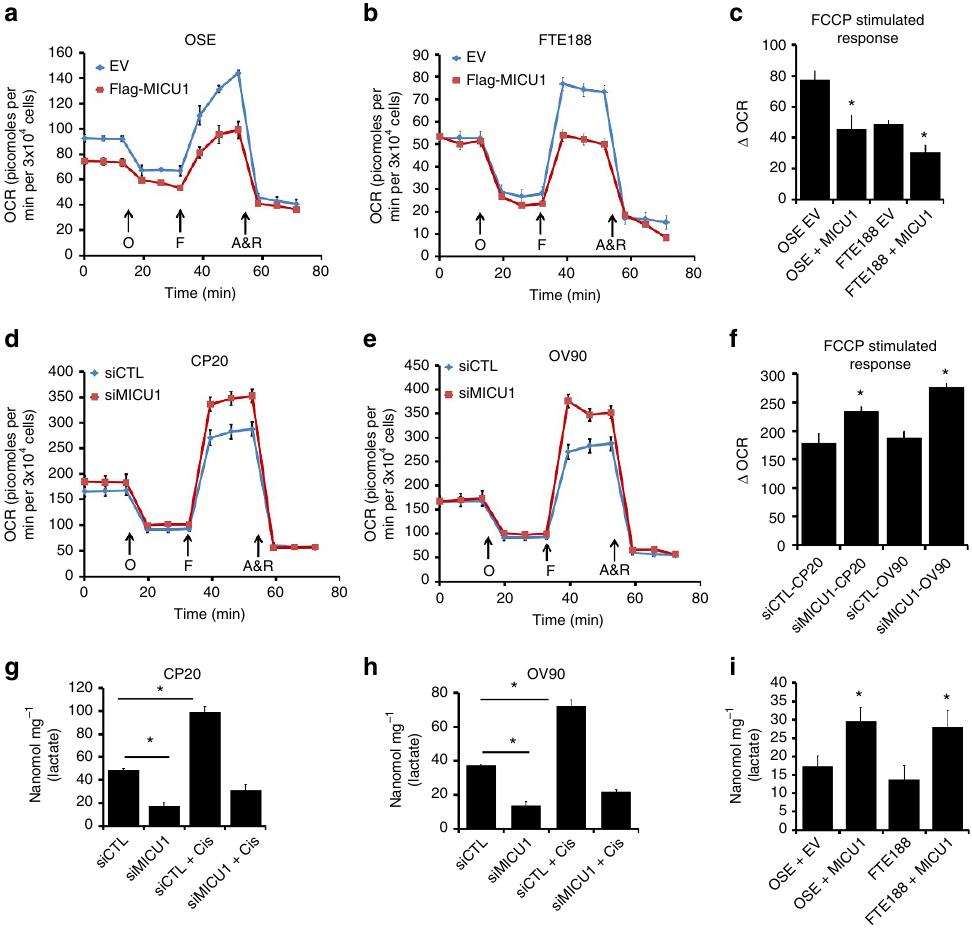
Figure 5 | MICU1 negatively regulates OxPhos function and induces lactate production. ( a , b ) Oxygen consumption rate (OCR) was measured using the Seahorse XF-96 analyser in OSE ( a ) and FTE188 cells expressing EV (empty vector) or FLAG-MICU1. An XF trace representing mean ± s.e.m. of at least three technical replicates per group is shown. Cells were sequentially treated with 2 m M Oligomycin (O), 0.5 m M FCCP (F) and 1 m M each of Antimycin þ Rotenone (A þ R) at indicated time points. ( c ) FCCP stimulated response were derived from the XF trace as in a , b from two independent experiments and represented as mean ± s.e.m. ( d ) CP20 and ( e ) OV90 cells were transfected with scrambled siRNA (siCTL) or MICU1 siRNA and the oxygen consumption rate (OCR) measured using the Seahorse XF analyser. An XF trace representing mean ± s.e.m. from at least three technical replicates per group is shown. ( f ) FCCP stimulated response were derived from the XF trace of two independent experiments and represented as mean ± s.e.m. ( g , h ) Intracellular lactate was measured in MICU1 silenced OV90 ( g ) and CP20 ( h ) cells with treatment with cisplatin 10 m M or vehicle and values represent mean ± s.d. ( i ) Intracellular lactate measurement in MICU1 overexpressing OSE and FTE188 cells as in g . * P o 0.05 statistically significant when compared to EV ( c , i ) siCTL ( f – h ). Comparisons between two groups were evaluated using two-sided Student’s t -test with unequal variances. Horizontal bar represents statistical comparison between respective groups. All the experiments were repeated independently at least three times and in